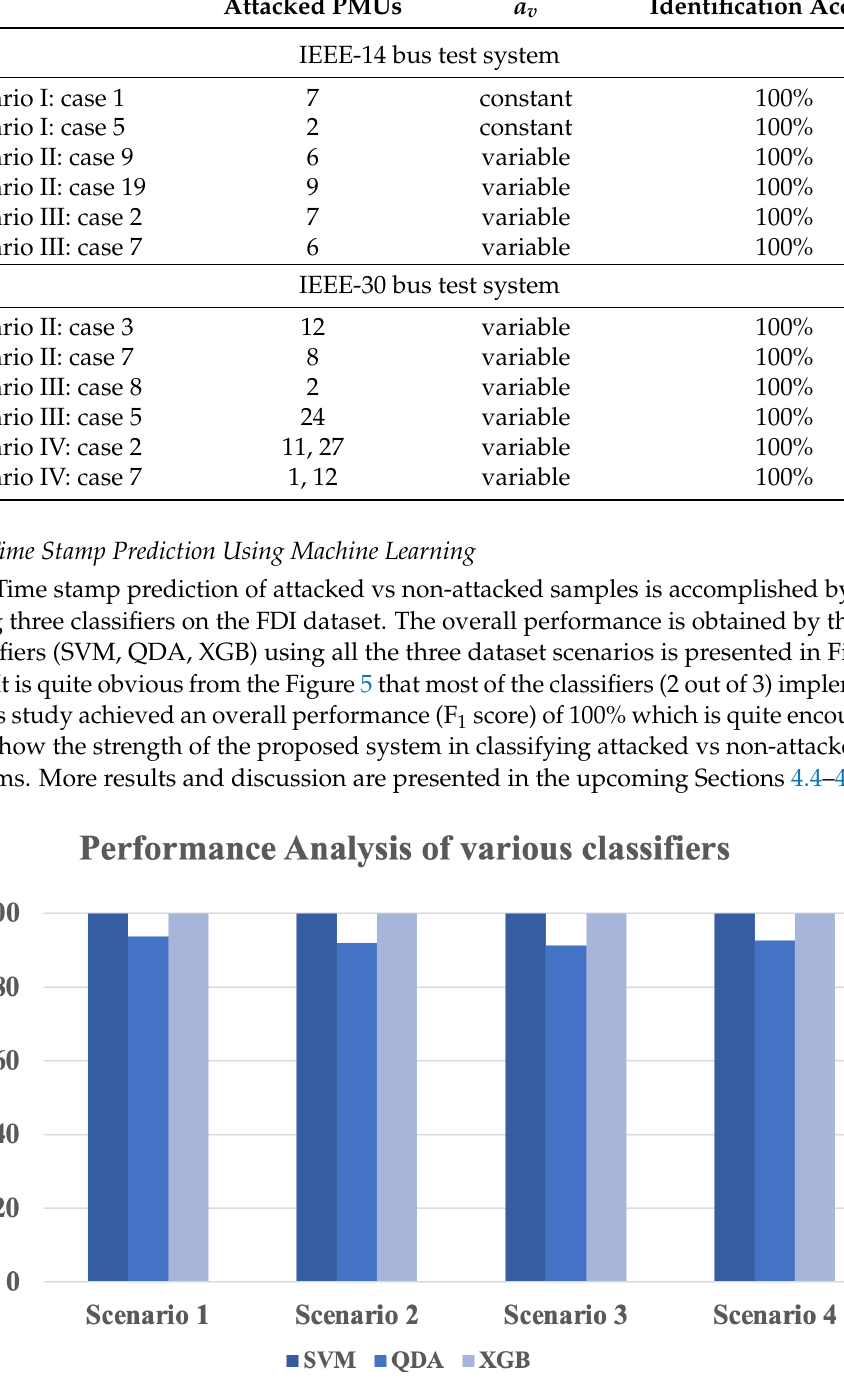
Figure 5. Performance analysis of various classifiers and data collection